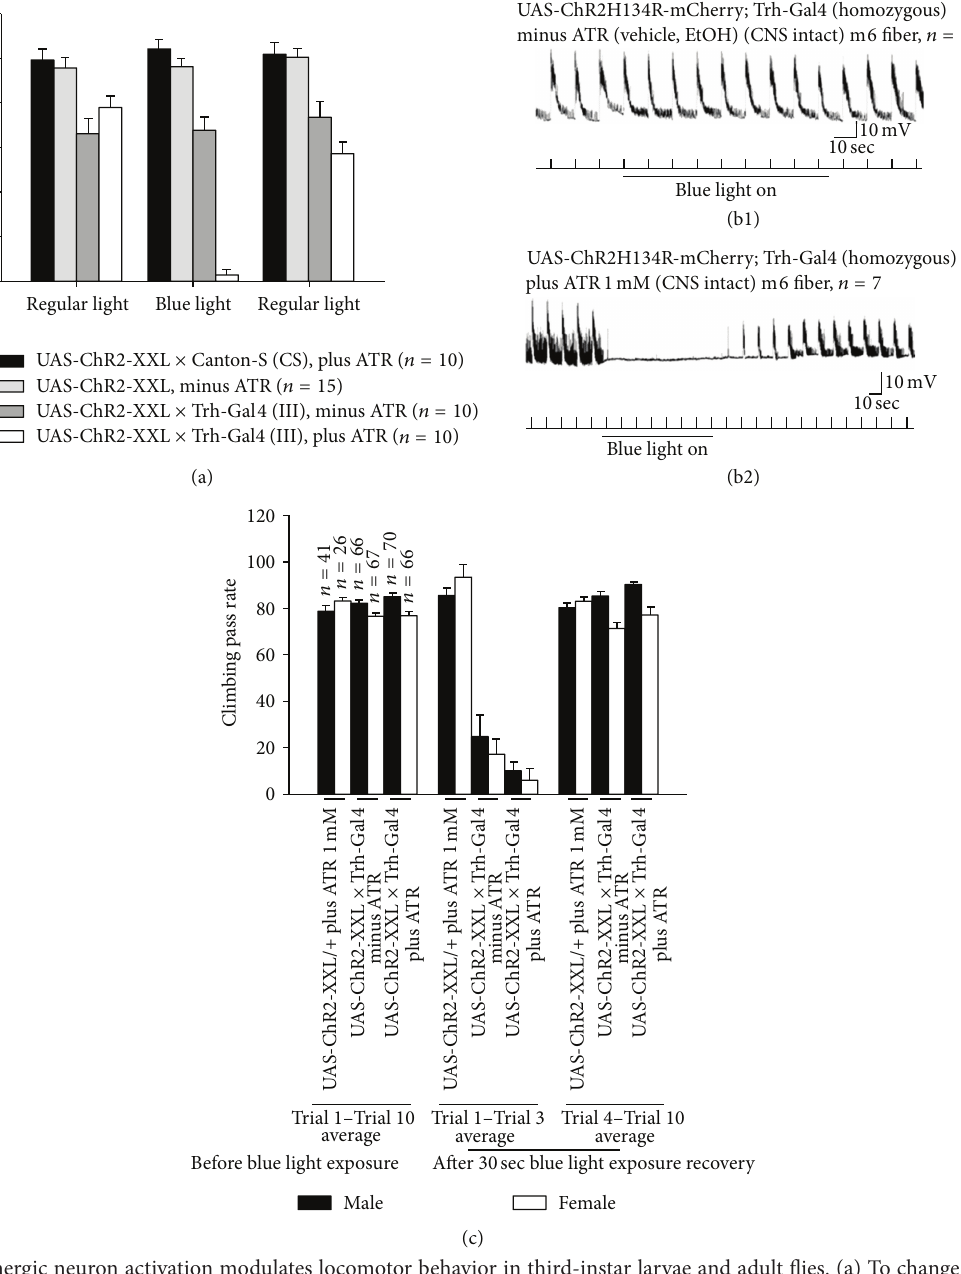
Figure 16: Serotonergic neuron activation modulates locomotor behavior in third-instar larvae and adult flies. (a) To change serotonergic neuron activity, ChR2 was expressed in serotonergic neurons (UAS-ChR2-XXL/+; Trh-Gal4/+). The body wall contractions were counted in third-instar larvae fed on food supplemented with ATR 1 mM or ethanol (vehicle). When the larvae, which were fed on ATR 1mM, were exposed to blue light, the locomotor activity was significantly compromised. However, when the larvae fed on a food without ATR (b1) supplementation were exposed to blue light, the locomotor activity was not significantly affected. Fly food not supplemented with ATR and exposed to blue light did not suppress sensorimotor activity in dissected third-instar larvae; however, (b2) serotonergic neuron activation by exposing the third-instar larvae, which were fed food supplemented with ATR (1mM), to blue light shut down sensory-motor circuit activity. The sensory-motor circuit was being activated by trains of stimulations at 40 Hz, 10 pulses, while the motor output was being recorded in abdominalmuscle6(m6).(c)Climbingassayinadultflieswasusedtotestthelocomotiveabilityoftheflies.Activationofserotonergicneurons in adult flies decreases climbing ability. The excitability of serotonergic neurons is increased by expressing and activating ChR2 by blue light. When the adult flies were being exposed to blue light, the climbing ability significantly reduced. Both flies groups (UAS-ChR2-XXL/+; Trh- Gal4/+) which were fed food supplemented with ATR 1mM or ethanol (vehicle) were affected by the blue light exposure. However, blue light did not have effect on the control lines (UAS-ChR2-XXL × Canton-S, shown as UAS-ChR2-XXL/+). The climbing assay was repeated 10 times and the average (Trial 1–Trial 10 average) was taken. There was a 1min rest interval between two trials before blue light exposure. Moreover, after exposing the flies to blue light for 30sec, the climbing assay was repeated for 10 trials. The average was taken for Trial 1–Trial 3 since the locomotion activity was decreased during this period. The average was taken for Trial 4–Trial 10, in which the flies started recovering after blue light